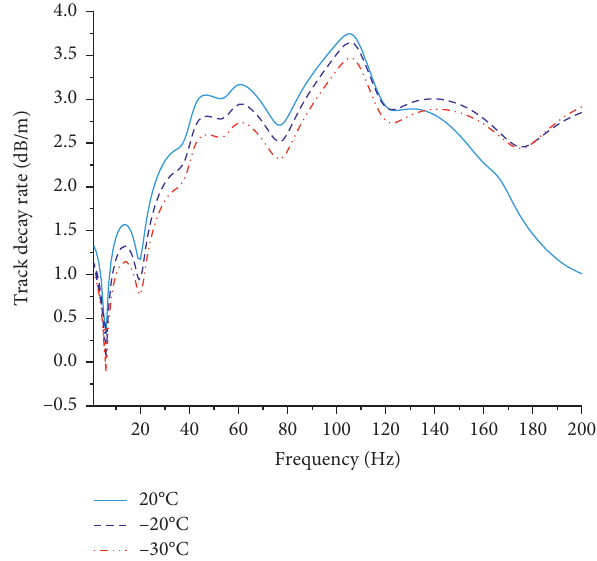
Figure 15: TDR of the track-bridge